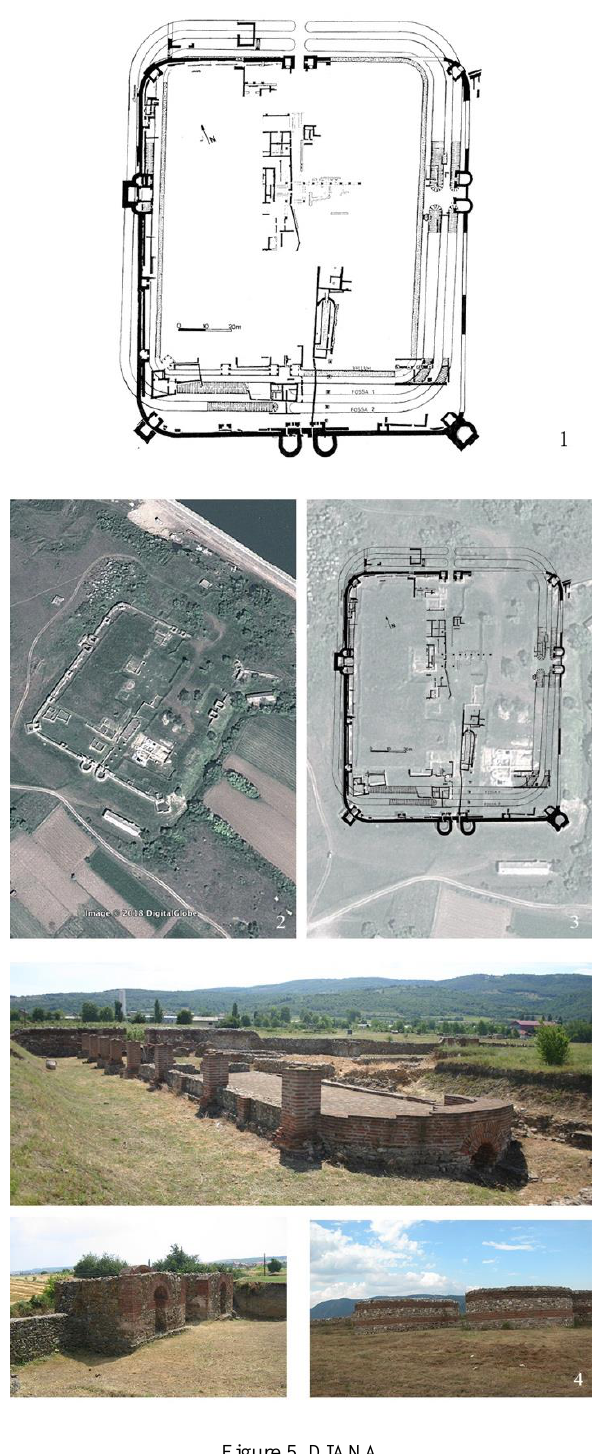
1: plan of the site (KONDIC, 1983-84); 2: Image of the area from Bing Maps. 3: elaboration by the author, Kondic plan on the aereal view of the site. 4: photographies of the actual situation of the site (http://limes2018.org/limes/diana/